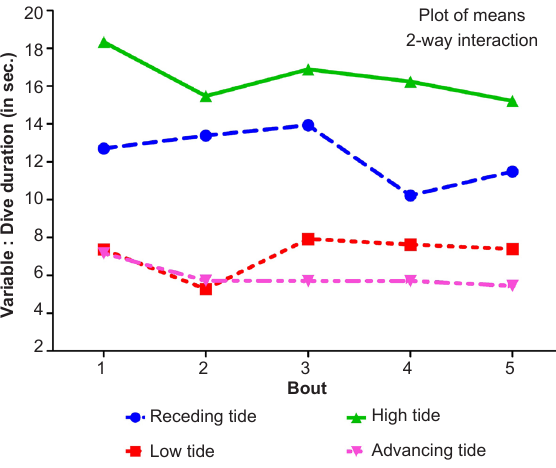
Figure 5. Box Whisker plot of dive/pause ratio at different tidal cycles.